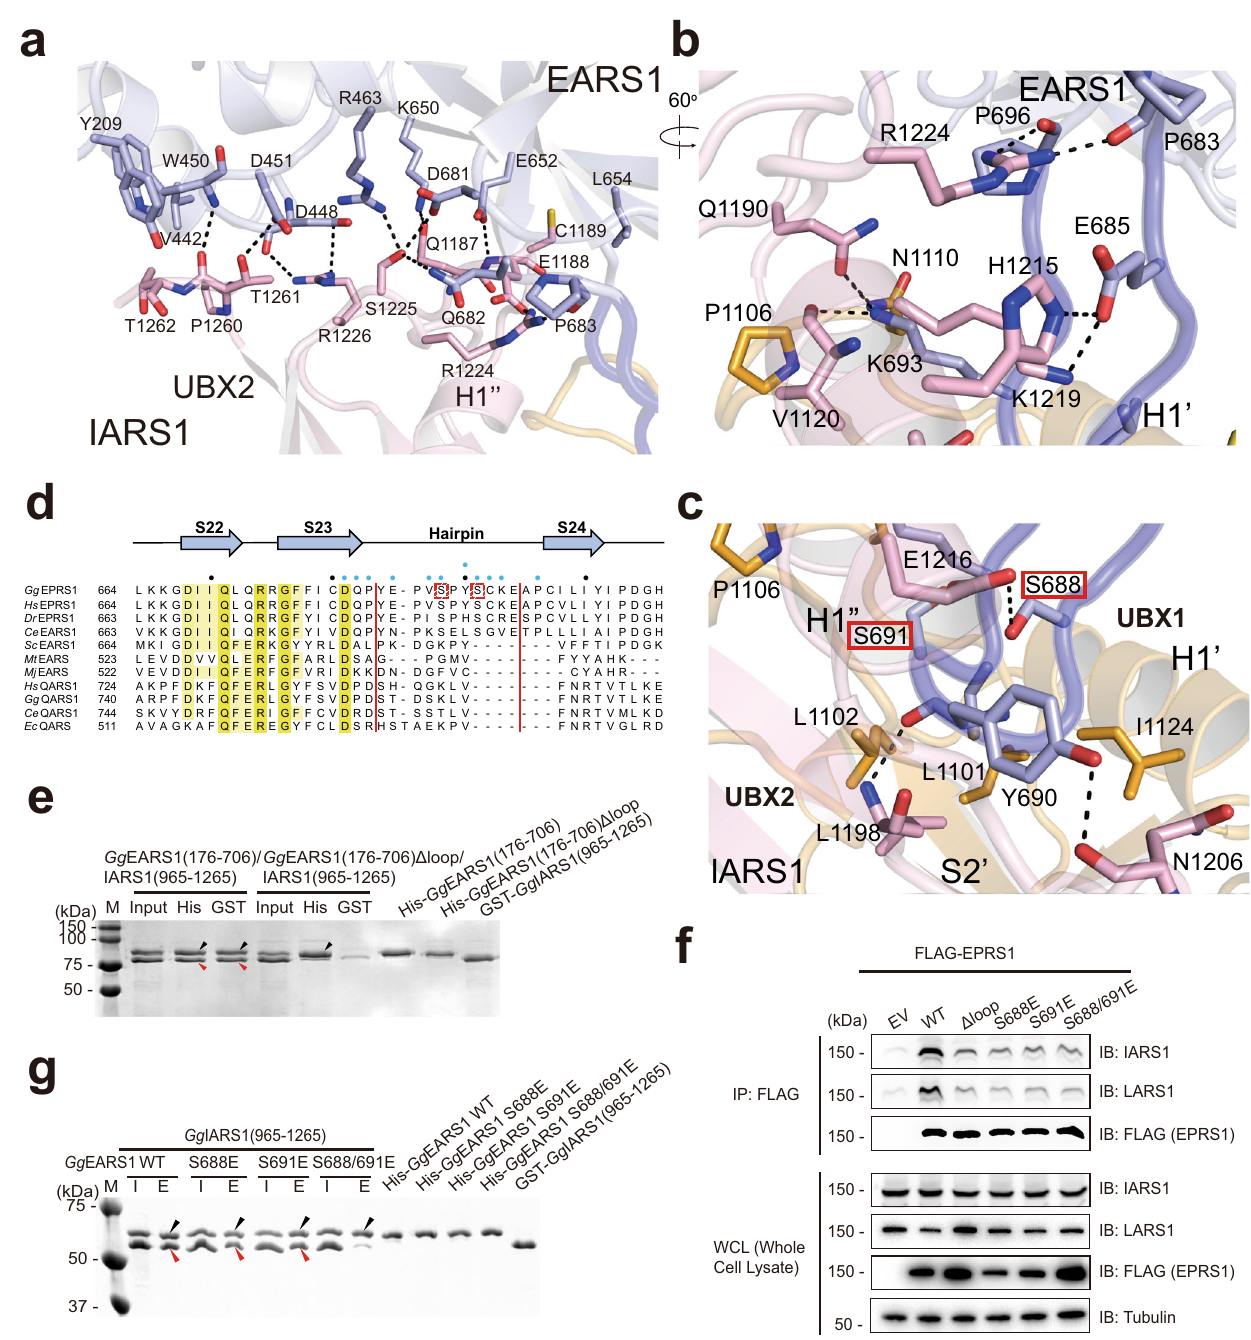
Fig. 2 | Interaction between the EARS1 hairpin loop and IARS1 UBX domains. a Close-upviewoftheinterfacebetweenEARS1andIARS1UBX2. b,c Close-upview of the interaction between the EARS1 hairpin loop and IARS1 UBX domains. Mutated residues in the pull-down analysis are indicated by red boxes. a – c Color schemesaresameasthoseinFig.1d.H-bondsandion-pairsareshowninblackdots. d Structure-based sequence alignments of EARS1 and QARS1 orthologs. The sec- ondary structure of Gg EARS1 is displayed on top of the sequences. IARS1- contactingresiduesareindicatedbybluecircles.Everytenthresidueismarkedwith ablackdot. e Invitropull-downassayof Gg EARS1andtheIARS1UNE-Idomain.His- Gg EARS1 or His- Gg EARS1 Δ hairpin was pulled down with Ni-NTA resin, and co- precipitated GST- Gg IARS1 was detected by Coomassie staining. Black and red